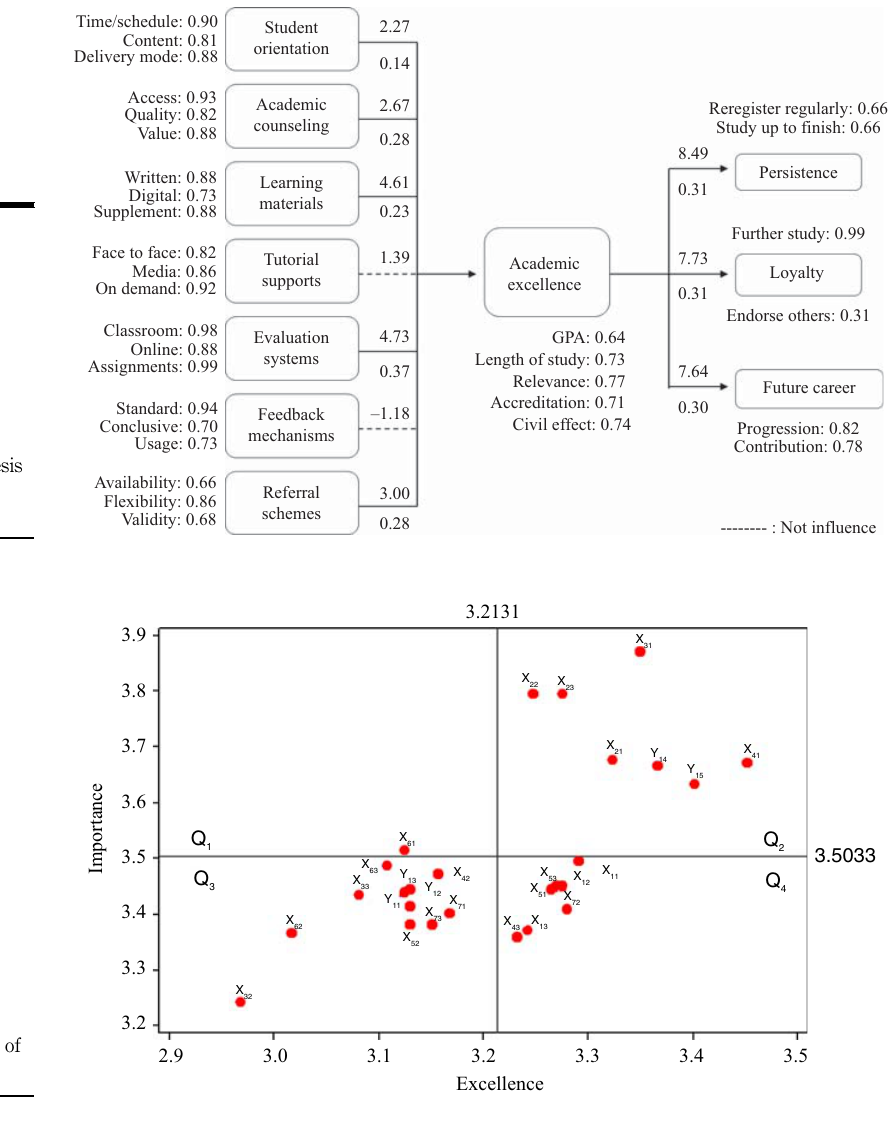
Figure 4. The IPA-CSI chart of the